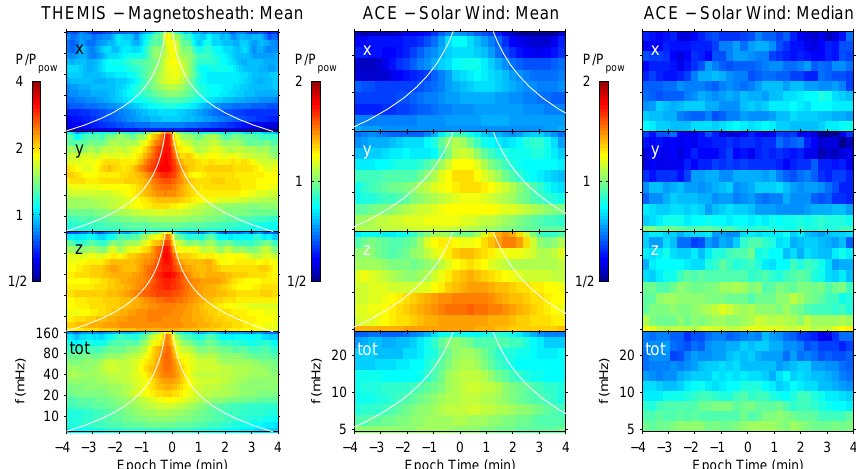
Fig. 6. Left: mean of the superposed wavelet power of the magnetosheath magnetic field. The median was similar. Middle and right: mean (middle) and median (right) of the superposed wavelet power of the solar wind magnetic field. The four panels show the power in the three GSE components of the magnetic field as well as the total. The respective mean background power law spectra P pow over all three components have been removed for clarity, with a similar procedure performed for the total power also. White lines indicate the Morlet wavelet cones of influence.